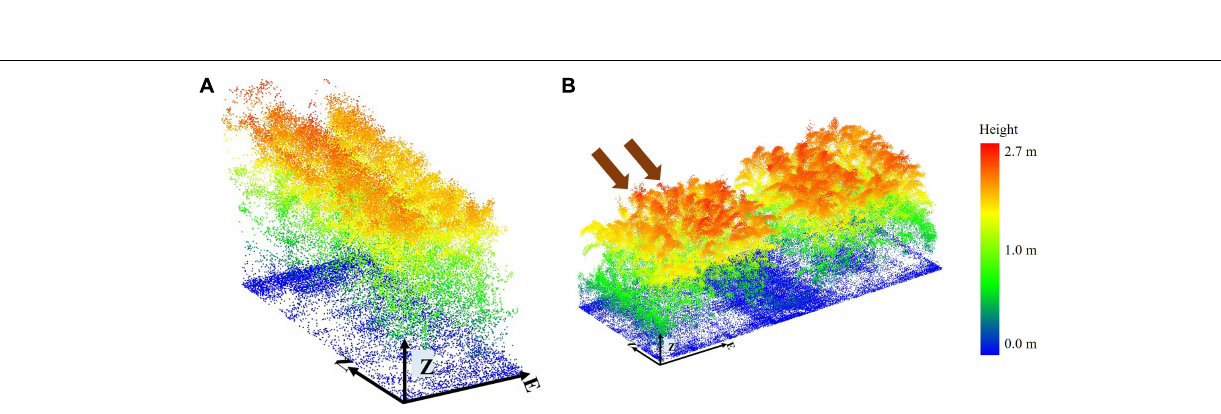
Frontiers in Plant Science |